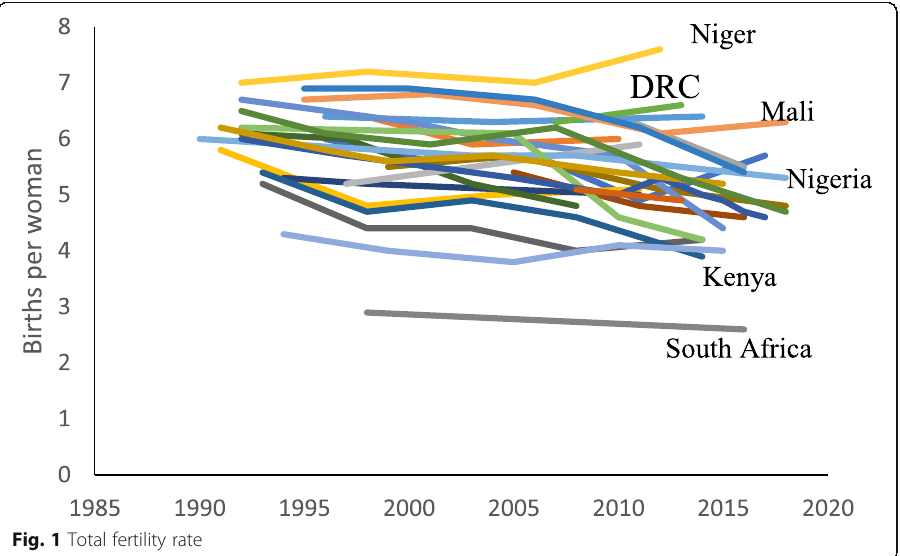
of 0.5 births per woman in the WTFR and a decline of 0.2 births per woman in the UWTFR. The average pace of decline (measured in births per woman per year) is 0.038